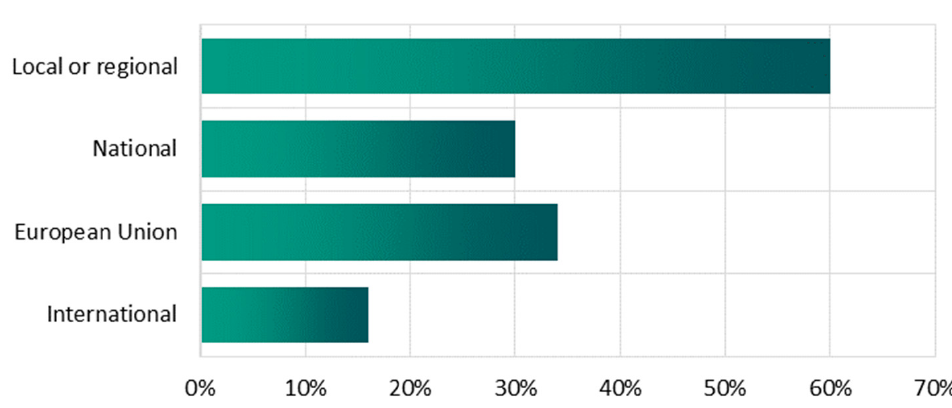
Figure 2. Level of policies addressed.